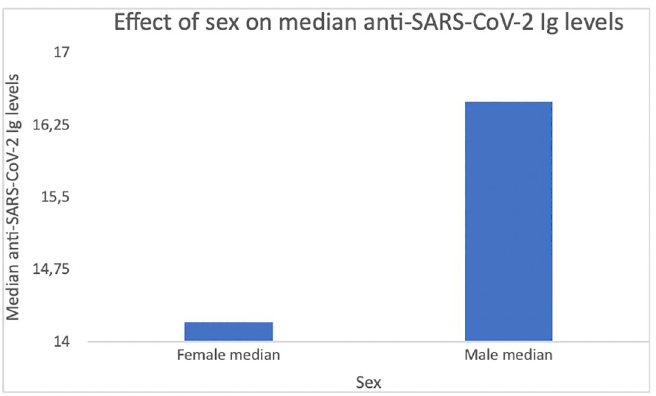
Fig 4. Effects of sex on median anti-SARS-CoV-2 Ig levels. The median anti-SARS-CoV-2 Ig level among individuals who tested positive was 18.9, interquartile range 43.9. Significantly higher median anti-SARS-CoV-2 Ig level was found in men when compared to women (20.40, IQR 49.72 vs 17.3, IQR 38.7; U = 3365817.50; p < 0.001).